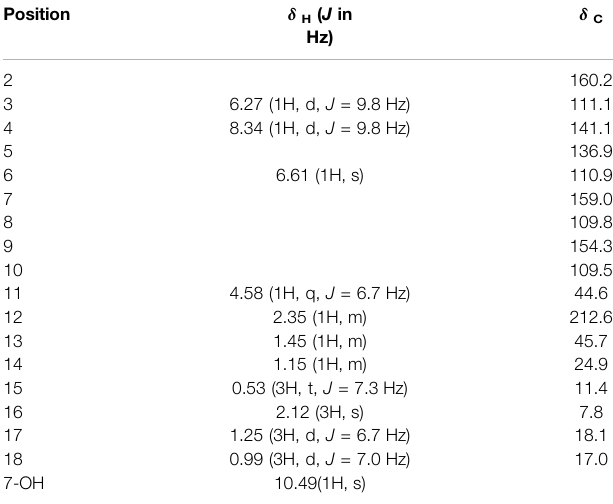
TABLE 1 | 1 H NMR and 13 C NMR spectral data in DMSO- d 6 for compound 1.x Position